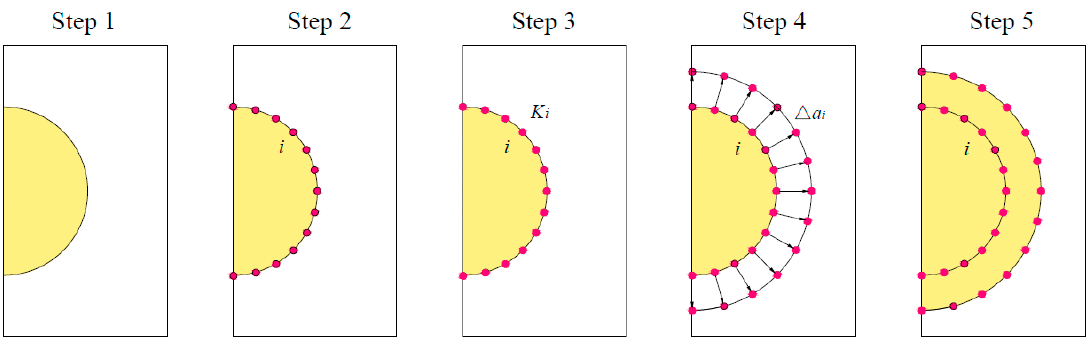
Figure 9. Five steps of the adaptive re-meshing technique [19].